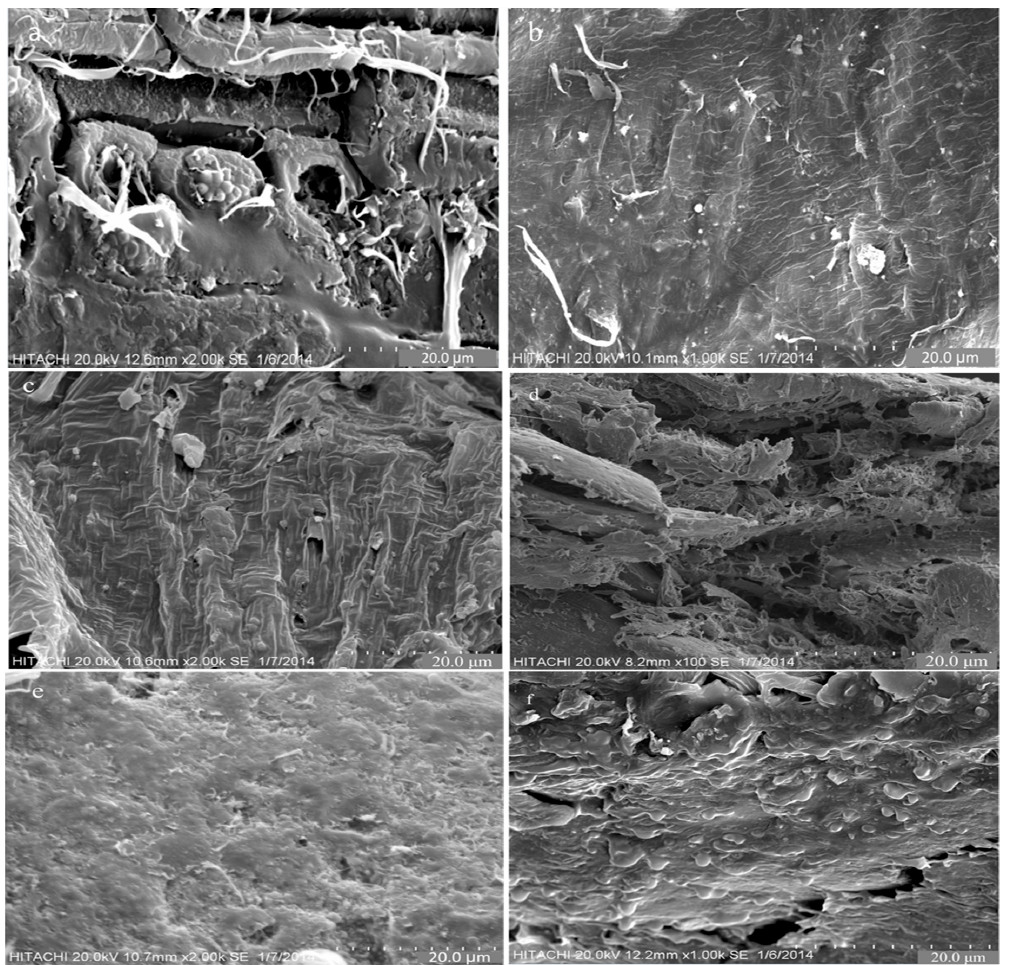
Figure 5. Scanning electron microscopy (SEM) micrographs of NZF + OPEFB + PCL for different percentages of NZF filler in the composites: ( a ) 2.5% NZF; ( b ) 5% NZF; ( c ) 7.5% NZF; ( d ) 10% NZF; ( e ) 12.5% NZF; ( f ) 15% NZF.